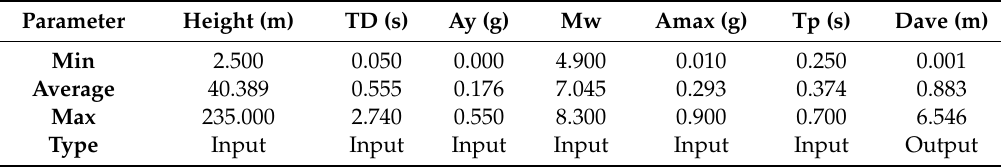
Table 1. Information on the parameters used in this